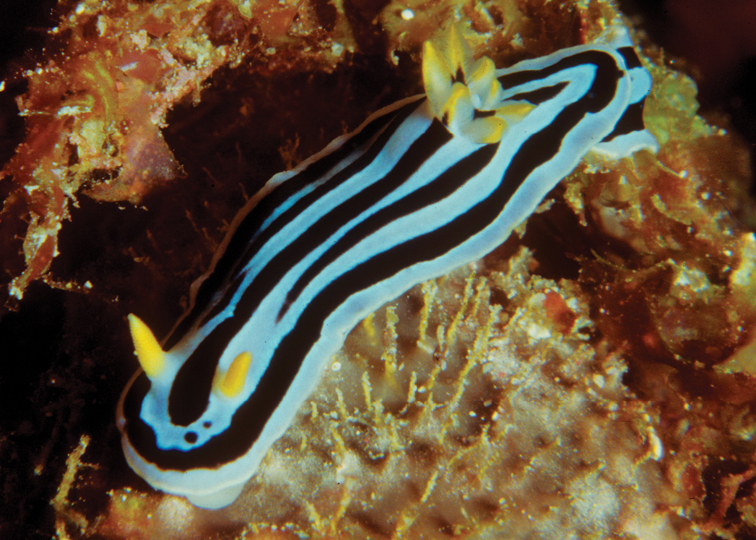
Chromodoris boucheti, Maldives, photo: J Hinterkircher (no spcm).